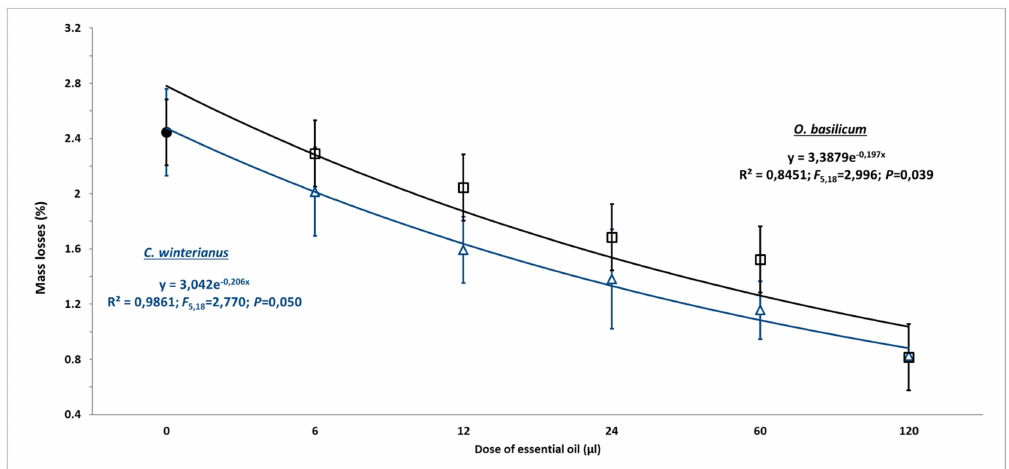
Figure 4. Bean weight losses caused by A. obtectus in 0.33 L / glass jar on the absence (control) ( (cid:8) ) and the presence of increasing doses of O. basilicum ( (cid:3) ) and C. winterianus ( ∆ ) essential oils. The symbols represent the mean of four replicates for each dose of essential oils. Vertical bars represent the Standard Error of the mean